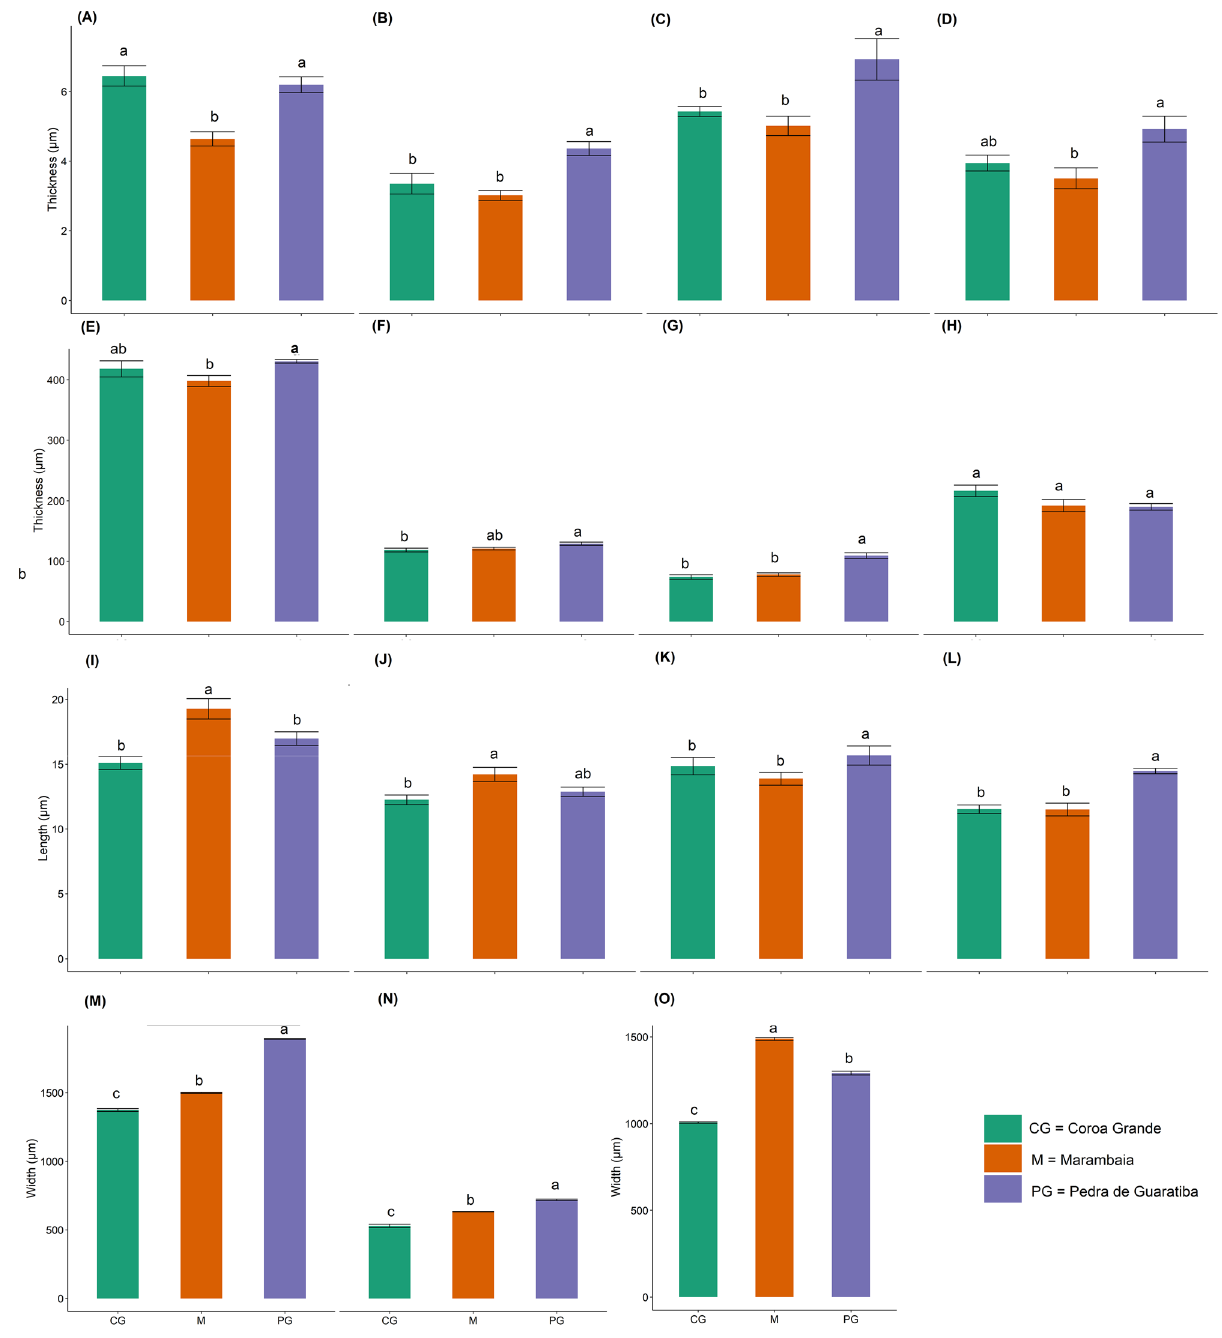
Figure 5. Light microscopy anatomical analysis of Laguncularia racemosa leaves collected in different mangroves in Rio de Janeiro (Brazil). Intercostal region: ( A ) thickness of adaxial wax + cuticle layer; ( B ) thickness of abaxial wax + cuticle layer; ( E ) thickness of mesophyll; ( F ) thickness of adaxial palisade parenchyma; ( G ) thickness of abaxial palisade parenchyma; ( H ) thickness of water storage parenchyma; ( I ) length of adaxial epidermal cells; ( J ) length of abaxial epidermal cells. Midvein region: ( C ) thickness of adaxial wax + cuticle; ( D ) thickness of abaxial wax + cuticle; ( K ) length of adaxial epidermal cells; ( L ) length of abaxial epidermal cells; ( M ) length of midvein region; ( N ) length of midvein; ( O ) width of midvein. Different letters indicate significant difference by Tukey’s HSD test ( P adj <